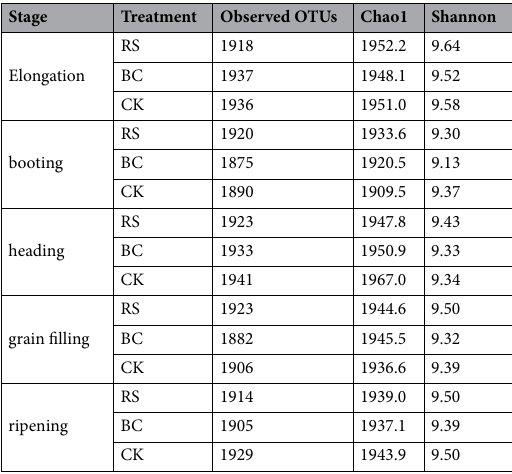
Table 1. Estimated operational taxonomic unit (OTU) richness and diversity indexes for soil samples from different stages of rice growth following 16S rDNA gene library clustering at 97% identity after Illumina Hiseq (2500) sequencing. Treatments: RS rice straw applied at 9000 kg ha −1 , BC biochar applied at 3150 kg ha −1 , CK soil without straw/biochar